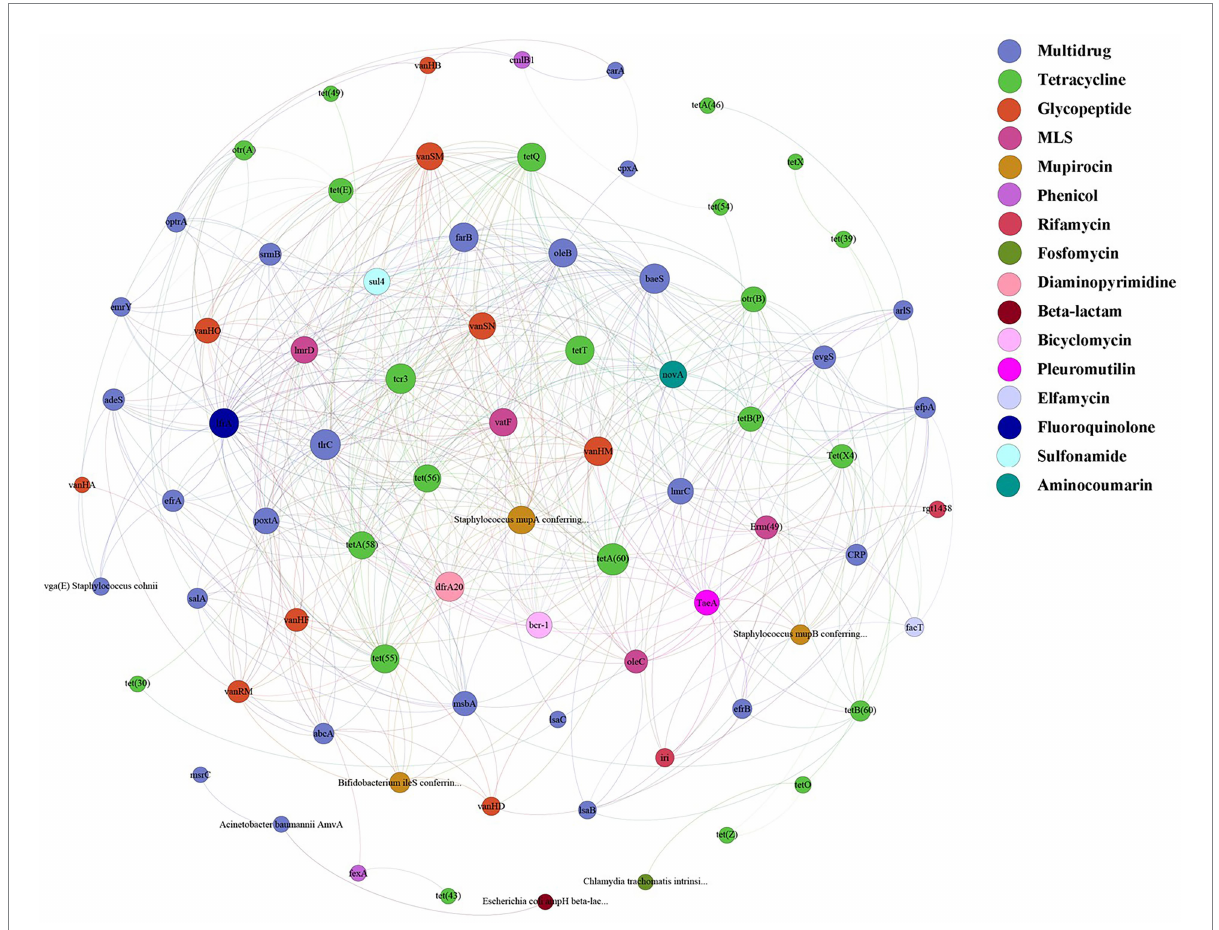
FIGURE 9 ARGs co-occurrence network of fungal resistance genes in AS phyllosphere. Nodes represent genes and are colored to indicate antimicrobial classes of